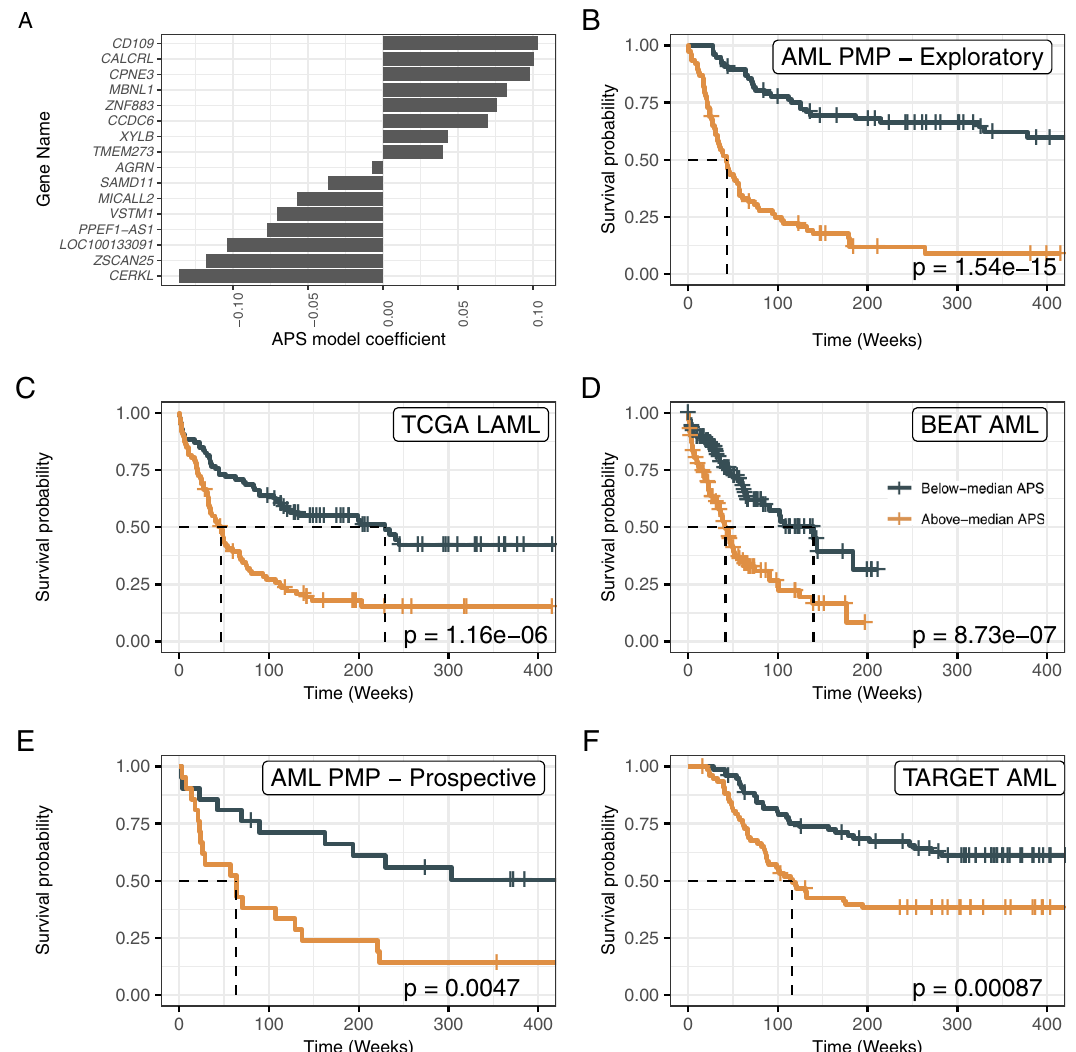
Fig. 3 Training and validation of the AML prognostic score (APS) gene expression signature. A APS model coef fi cients. The y -axis indicates the genes making up the APS set, with the x -axis indicating the model coef fi cients. B – F Survival plots for the AML PMP ( B , n = 154), TCGA LAML ( C , n = 173), Beat AML ( D , n = 293), AML PMP Prospective ( E , n = 42), and TARGET pediatric AML ( F , n = 156) cohorts, for above-median and below-median values of the APS value within each cohort. Dashed lines indicate time to median survival. Log-rank p values are indicated for each